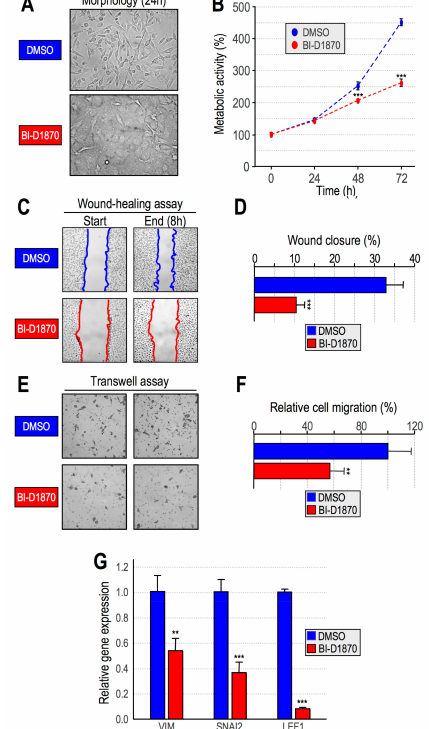
Figure 4. Ribosomal protein S6 kinase alpha-3 (RSK2) activity is essential in MDA-MB–231 cells to maintain a mesenchymal phenotype and cell motility. ( A ) Optical microscope images